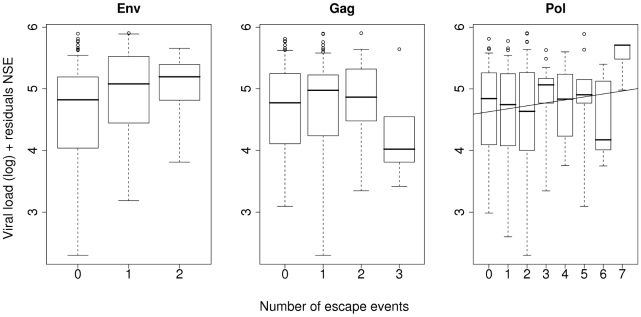
The number of escaped events (NEE) against log viral load, corrected by the number of synonymous epitopes (NSE), stratified by gene.Data used in Figure 2 was stratified by each HIV gene and the multiple linear regression repeated. Only escape events in pol were statistically significant independent predictors of log viral load (p = 0.0059, gradient = 0.14, line of best fit drawn), escape events in all other genes were not significant (data not plotted for genes nef, rev, vif and vpr, see Table S3).